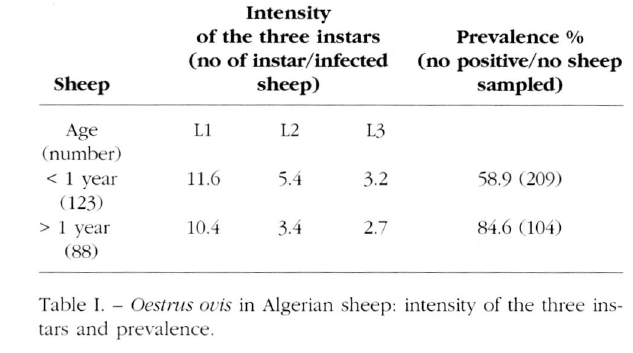
in January to 33-1 % in April, when it then increases steadily from May to December (47.4 to 77.1 % ). Sea sonal differences were recorded for the three instars (L1: p = 0.006; L2: p = 0.009; L3: p = 0.046)